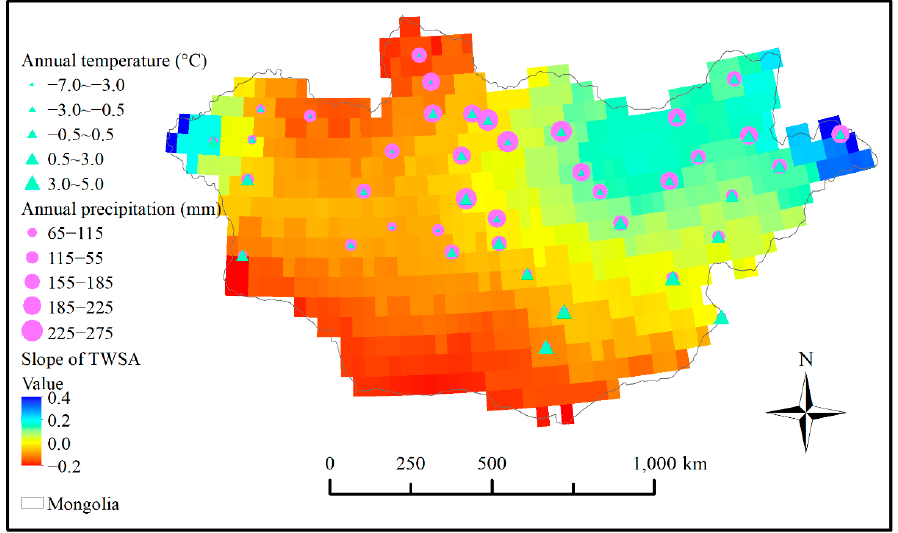
Figure 4. The distribution of the Thiel − Sen’s slope of TWSA and mean annual air temperature and annual precipitation for each meteorological station.